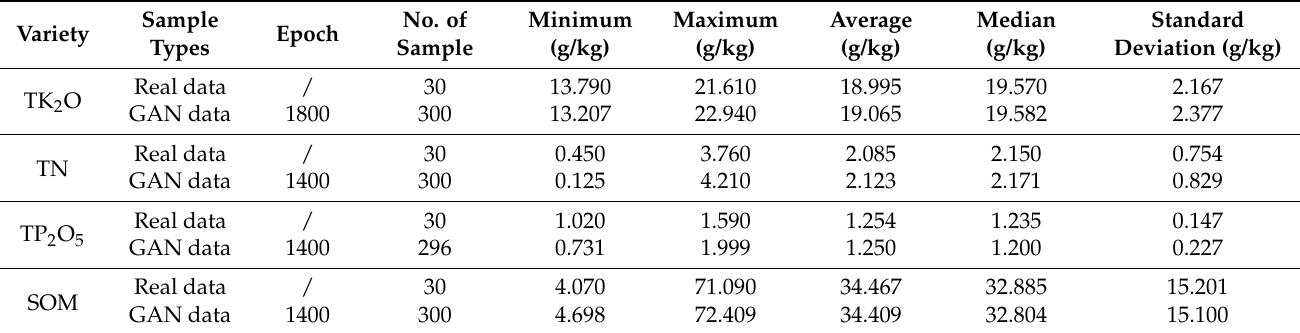
Table 3. Statistical results of true and fake data for the four